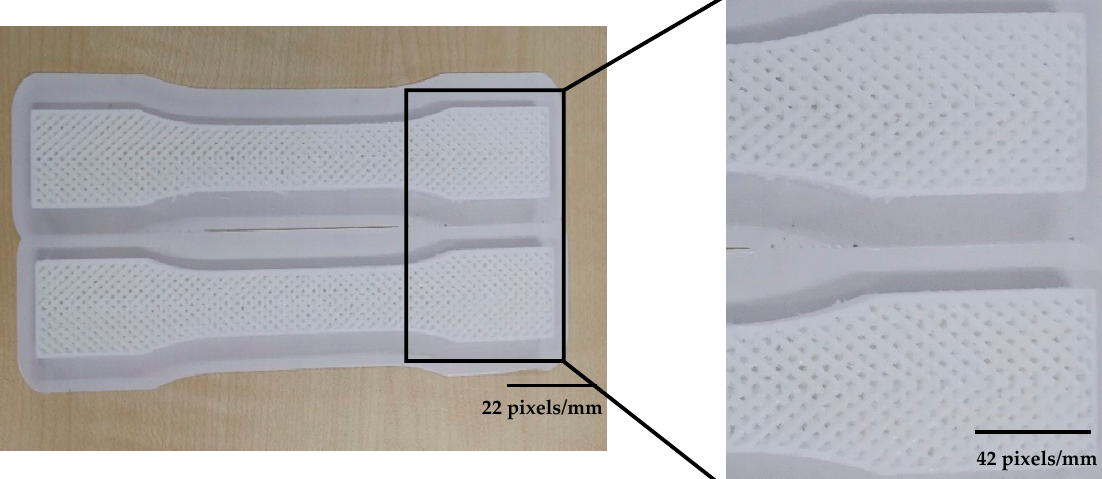
Figure 9. Quality of sample in 0° orientation.